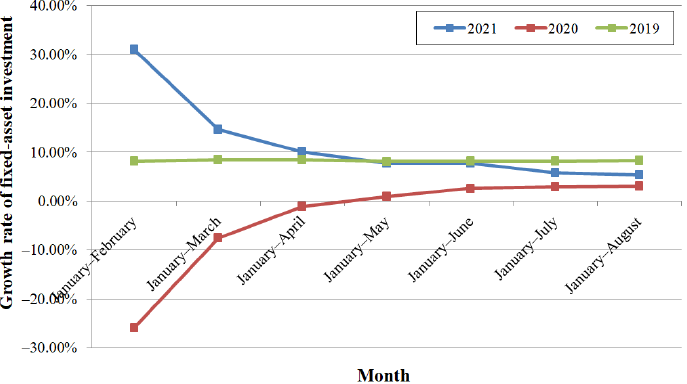
Figure 9. The YoY growth rate of fixed-asset investment.